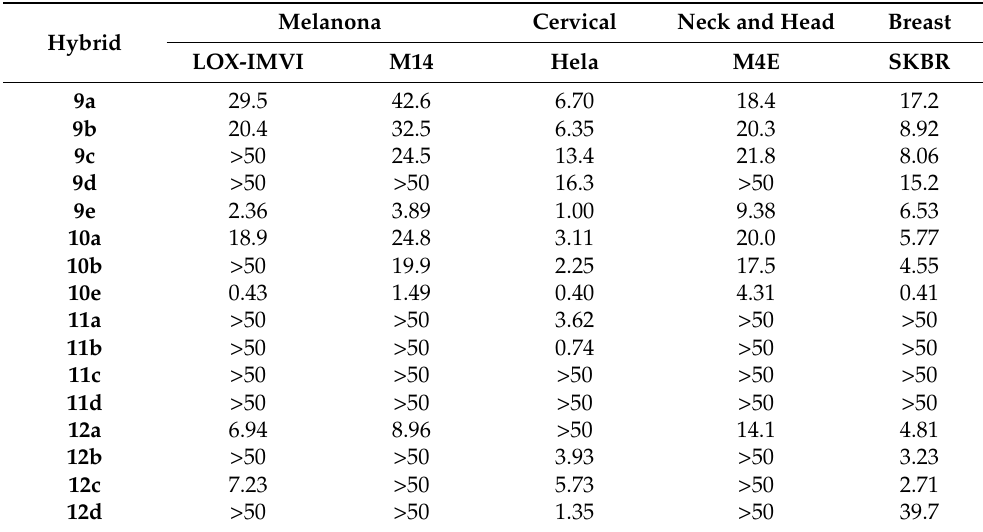
Table 2. The in vitro anticancer activities of hybrid nitrates 9 – 12 in melanoma, cervical, neck and head, and breast cancer cell lines (IC 50 in µ M) [42]. Melanona Cervical Neck and Head Breast Hybrid LOX-IMVI M14 Hela M4E